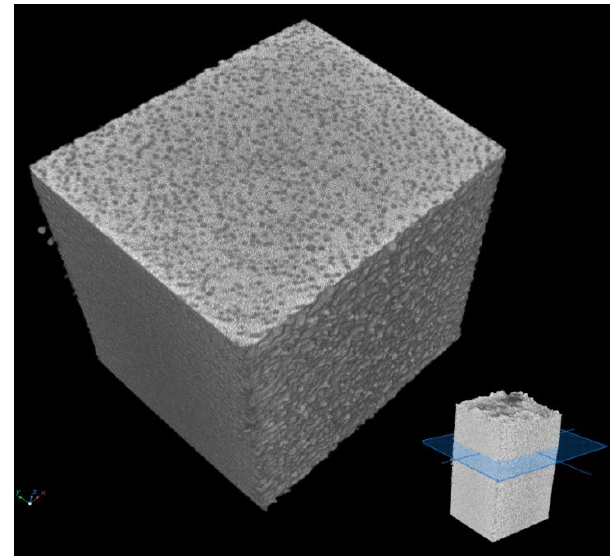
Figure 6. CT image of a ductile iron sample.